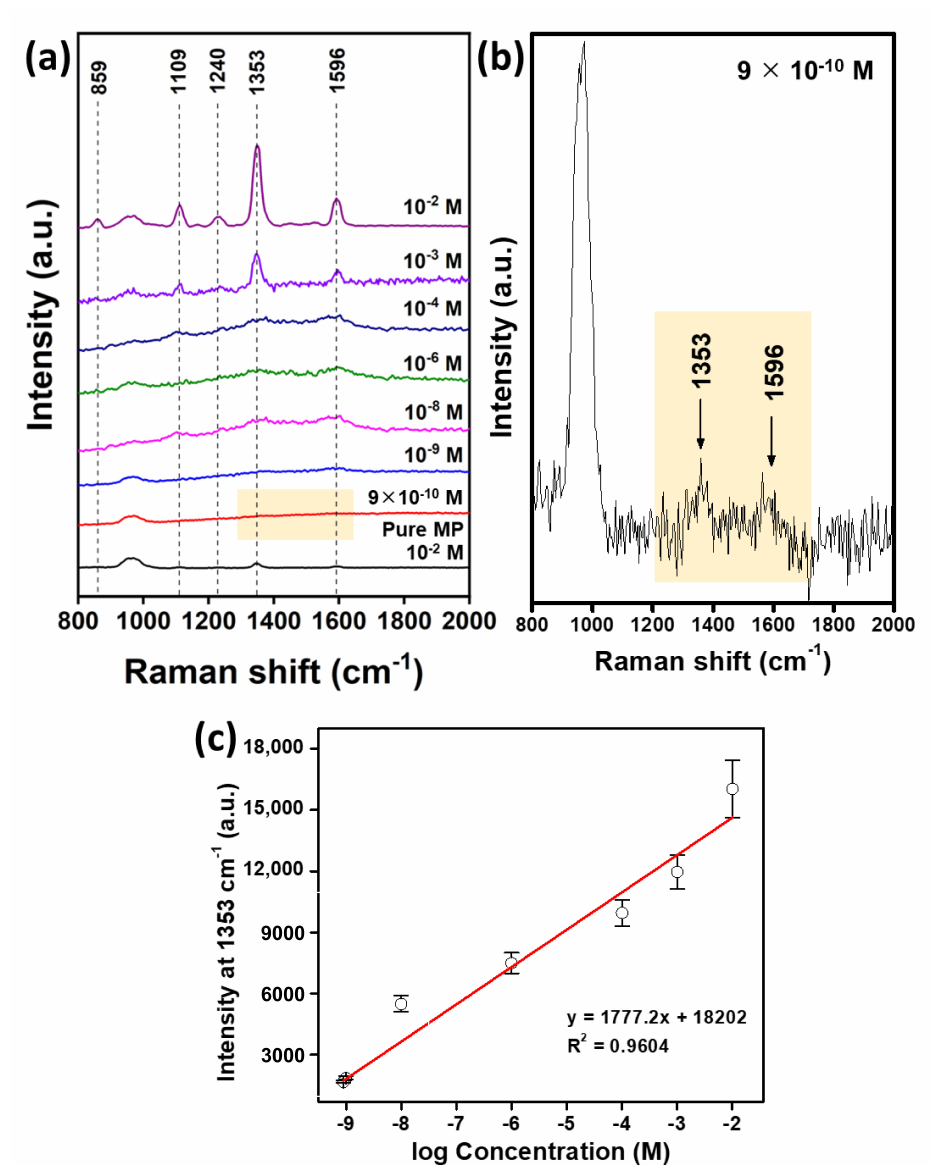
Figure 5. ( a ) SERS spectra of methyl parathion at different concentrations. ( b ) A zoomed-in view of the rectangle in ( a ), showing the intensity signal of 9 × 10 − 10 M methyl parathion. ( c ) Linear calibration plot between the SERS intensity (peak at 1353 cm − 1 ) and methyl parathion